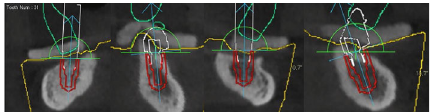
Figure 3: The CBCT scan. Coronal mandibular view. Four implants were placed in the 3.2, 3.4, 4.1, and 4.3 teeth regions. Distal implants are tilted at 29 degrees.